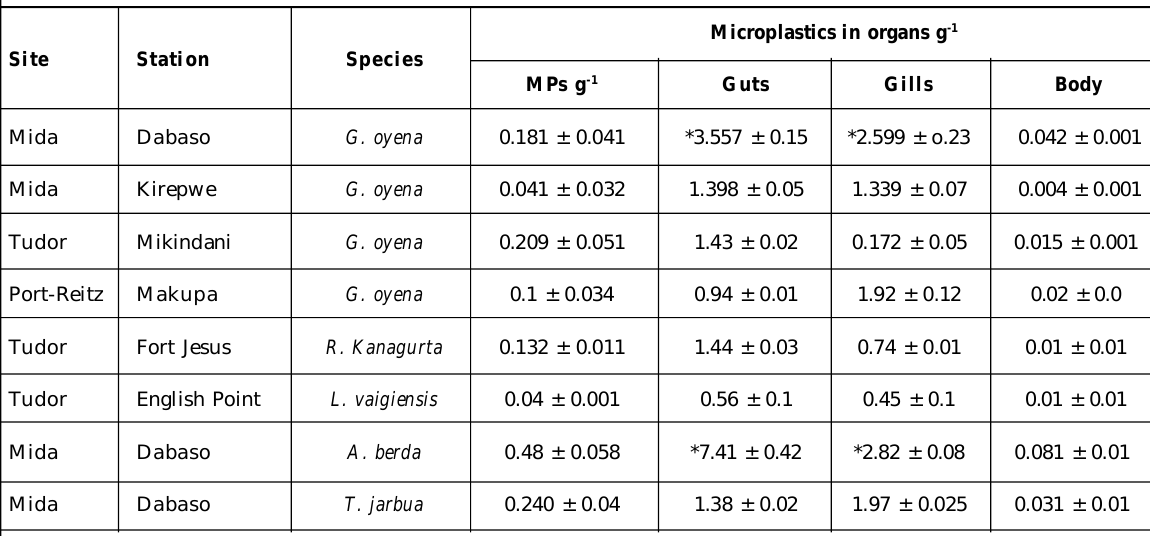
Table 7: Mean (x ± SE) concentration of microplastics in various organs per gram tissue of the different fish species